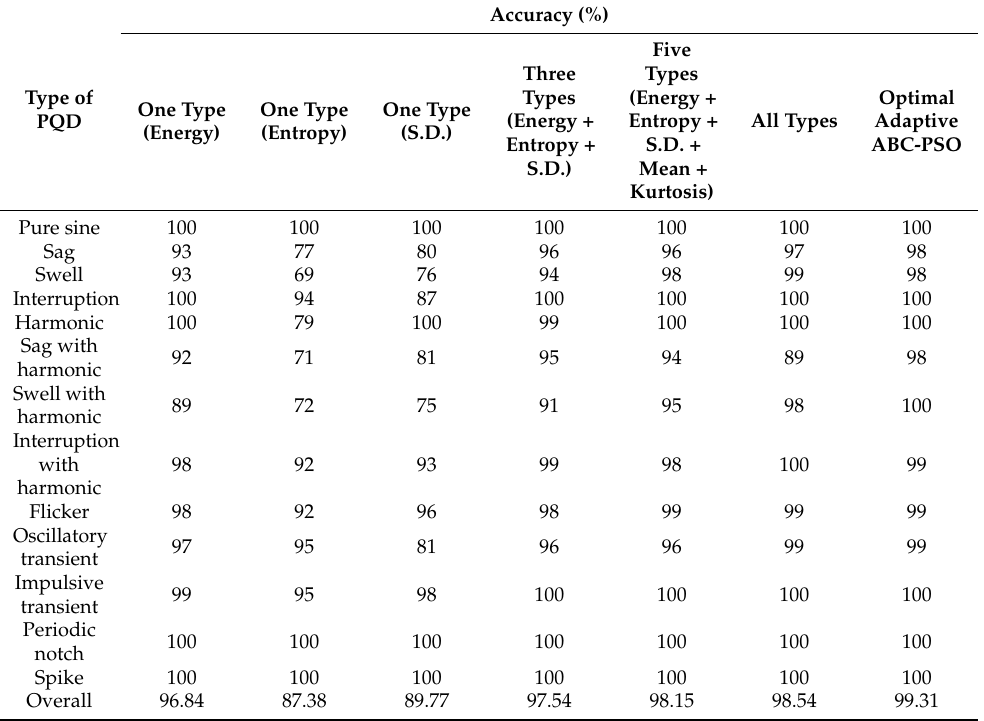
Table 6. Classification accuracy.